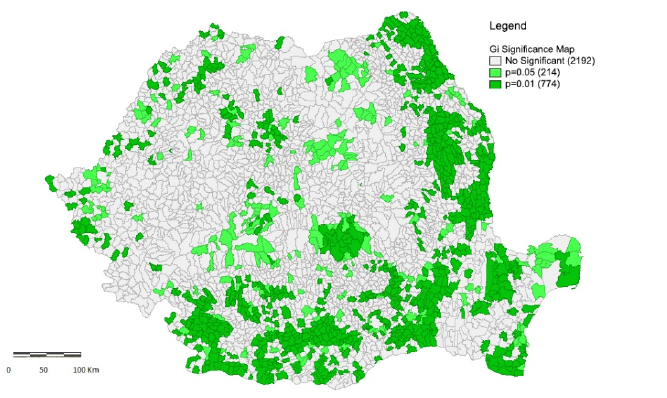
Figure 4: Moran significance map for number of accommodation companies per LAU (local administrative unit)